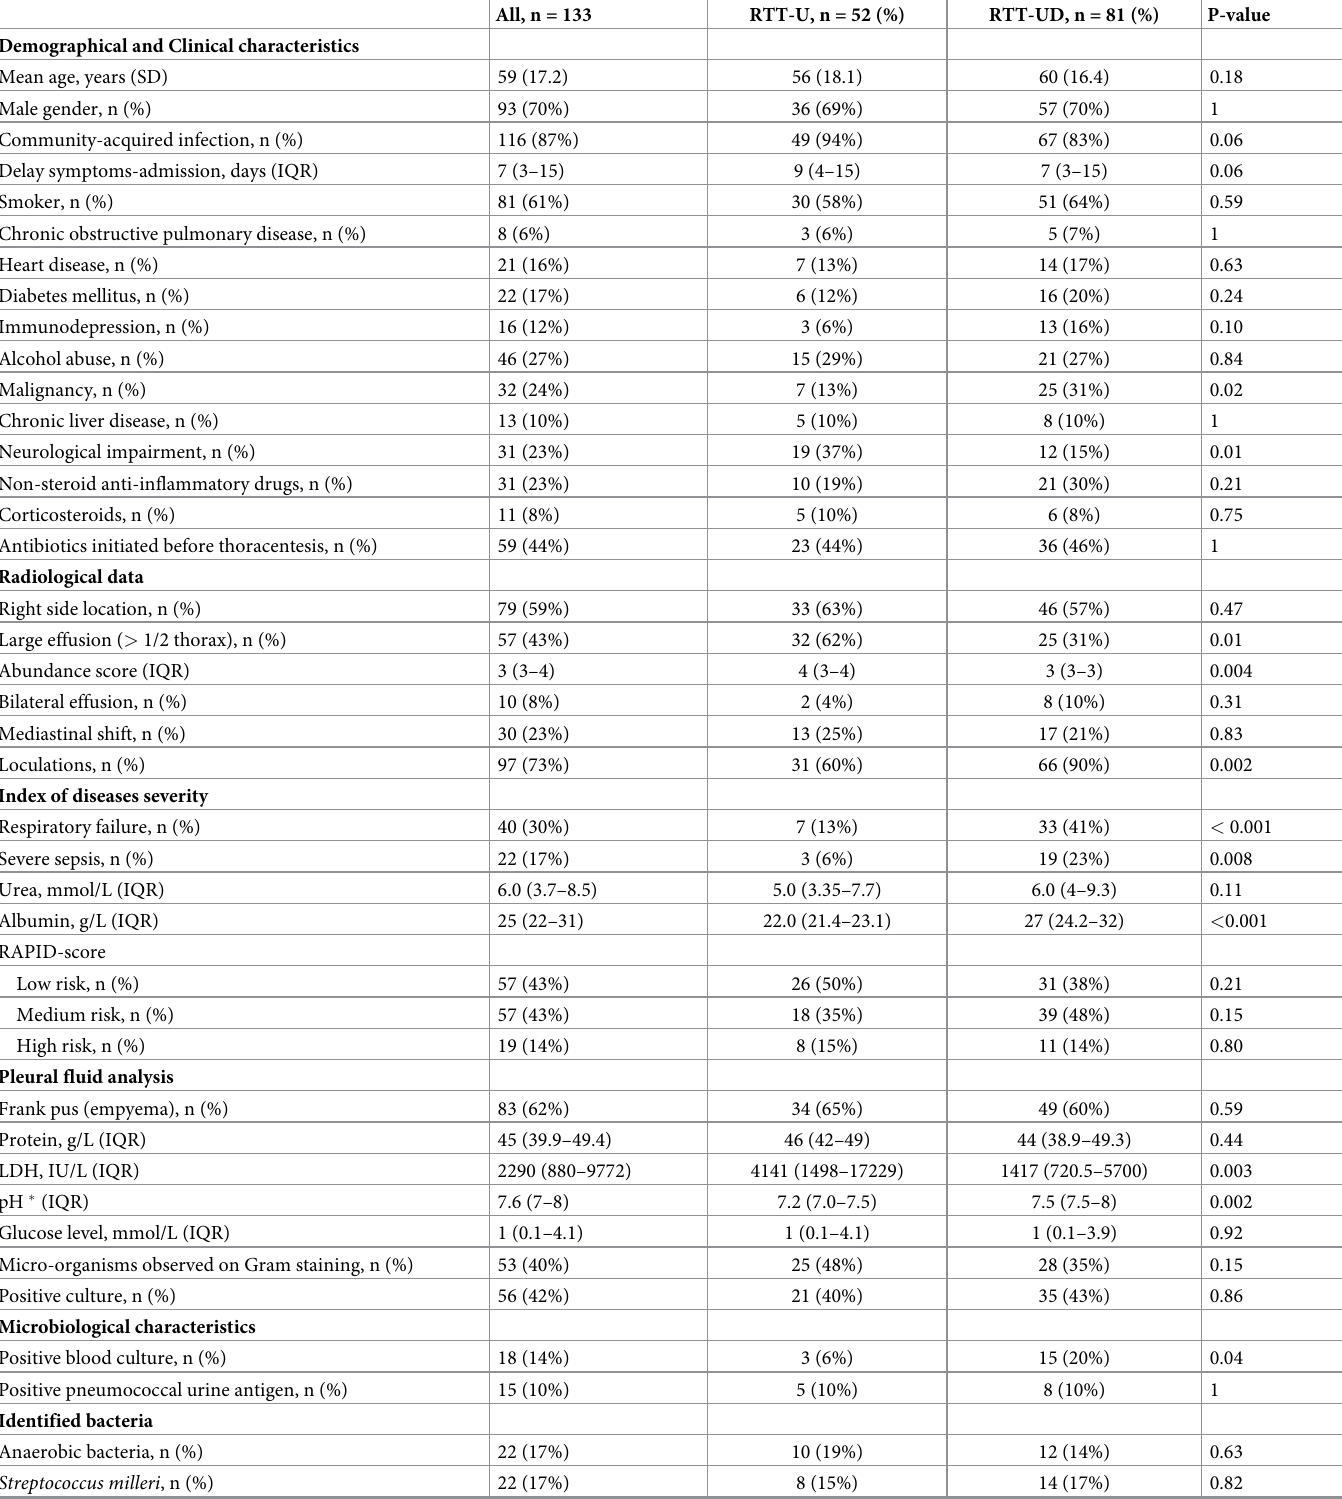
Table 1. Baseline characteristics of the study